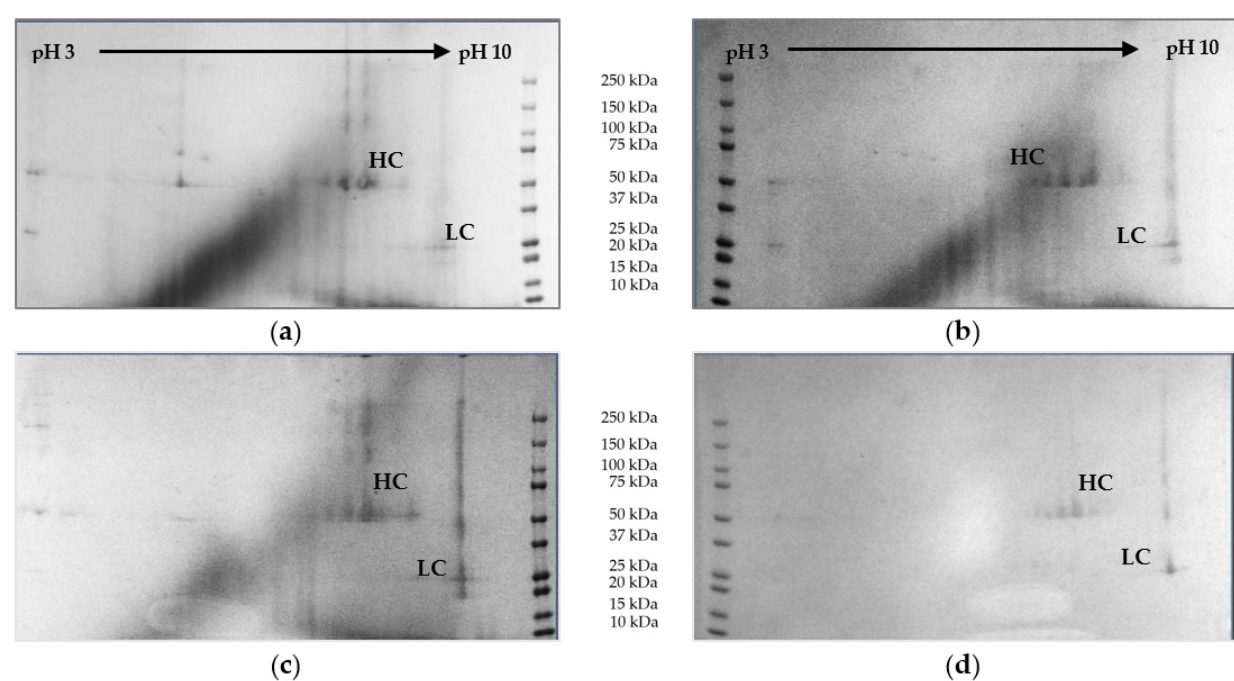
Figure 12. Two-dimensional (2D) SDS-PAGE gels of ( a ) light phase after ATPE, ( b ) cultivation broth, ( c ) dissolved mAb after precipiation, ( d ) mAb fraction after chromatography. LC: light chain of mAb. HC: heavy chain of mAb.